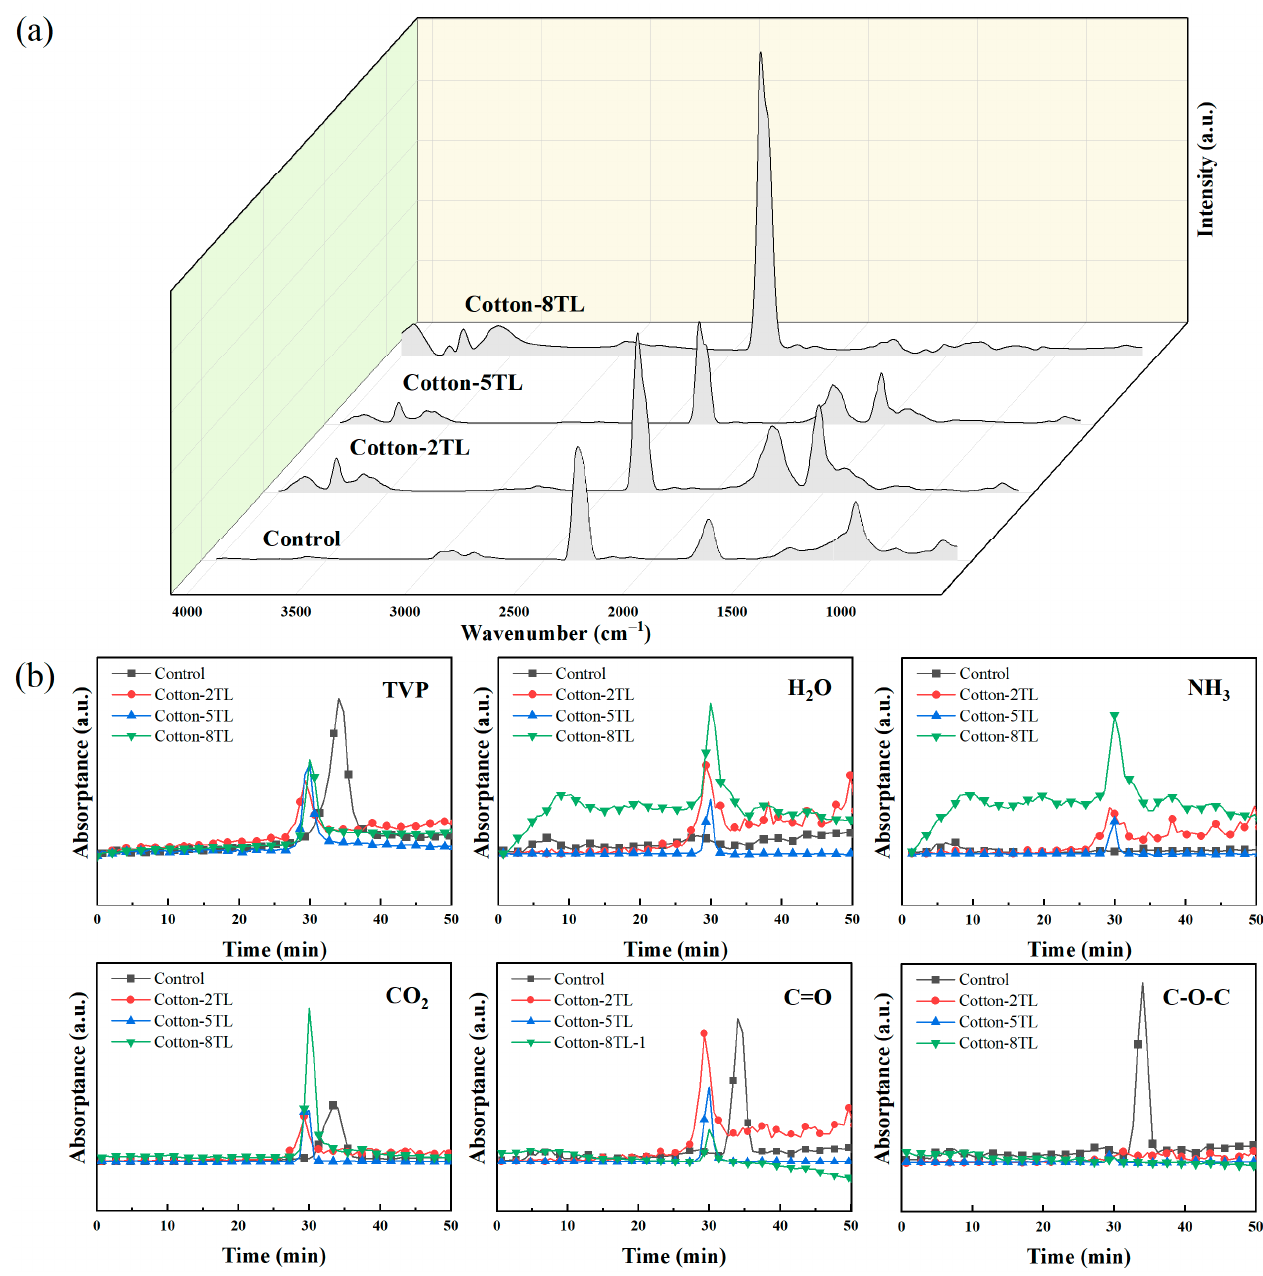
Figure 6. ( a ) FTIR spectra at T max and ( b ) FTIR absorbance of decomposed volatiles of the control and FR cotton fabrics.